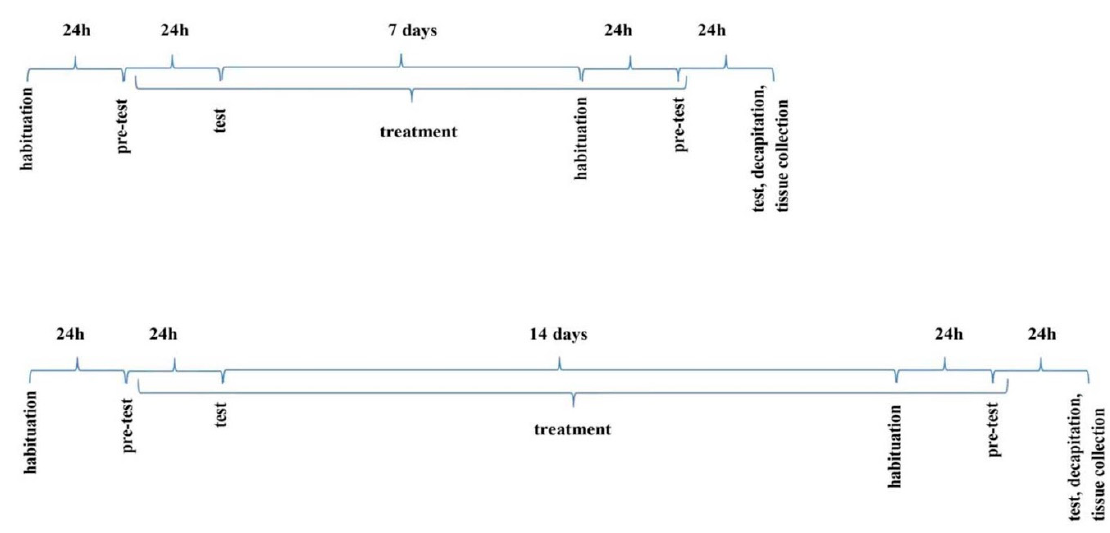
Figure 8. The schedule of administration of the compound D2AAK1 (i.p.) in the NOR and mEPM paradigms.